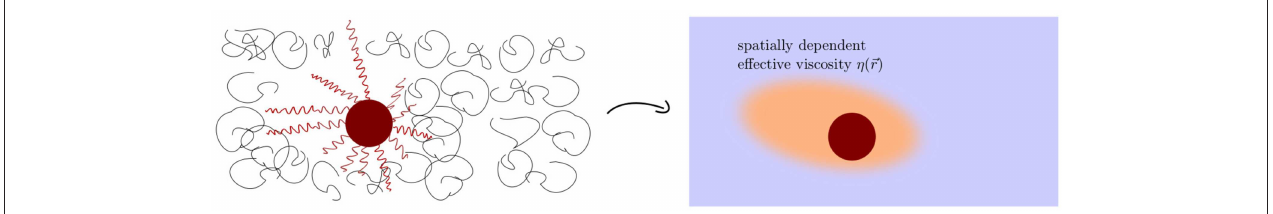
FIGURE 1 | Sketch of an anisotropic polymer concentration profile around a DNA-grafted colloid in a non-adsorbing polymer solution. The concentration profile of the free polymers depends on the grafting density and length of the DNA strings [32]. The anisotropic concentration profile leads to a non-uniform viscosity variation. We want to stress that the system is in equilibrium and there is no